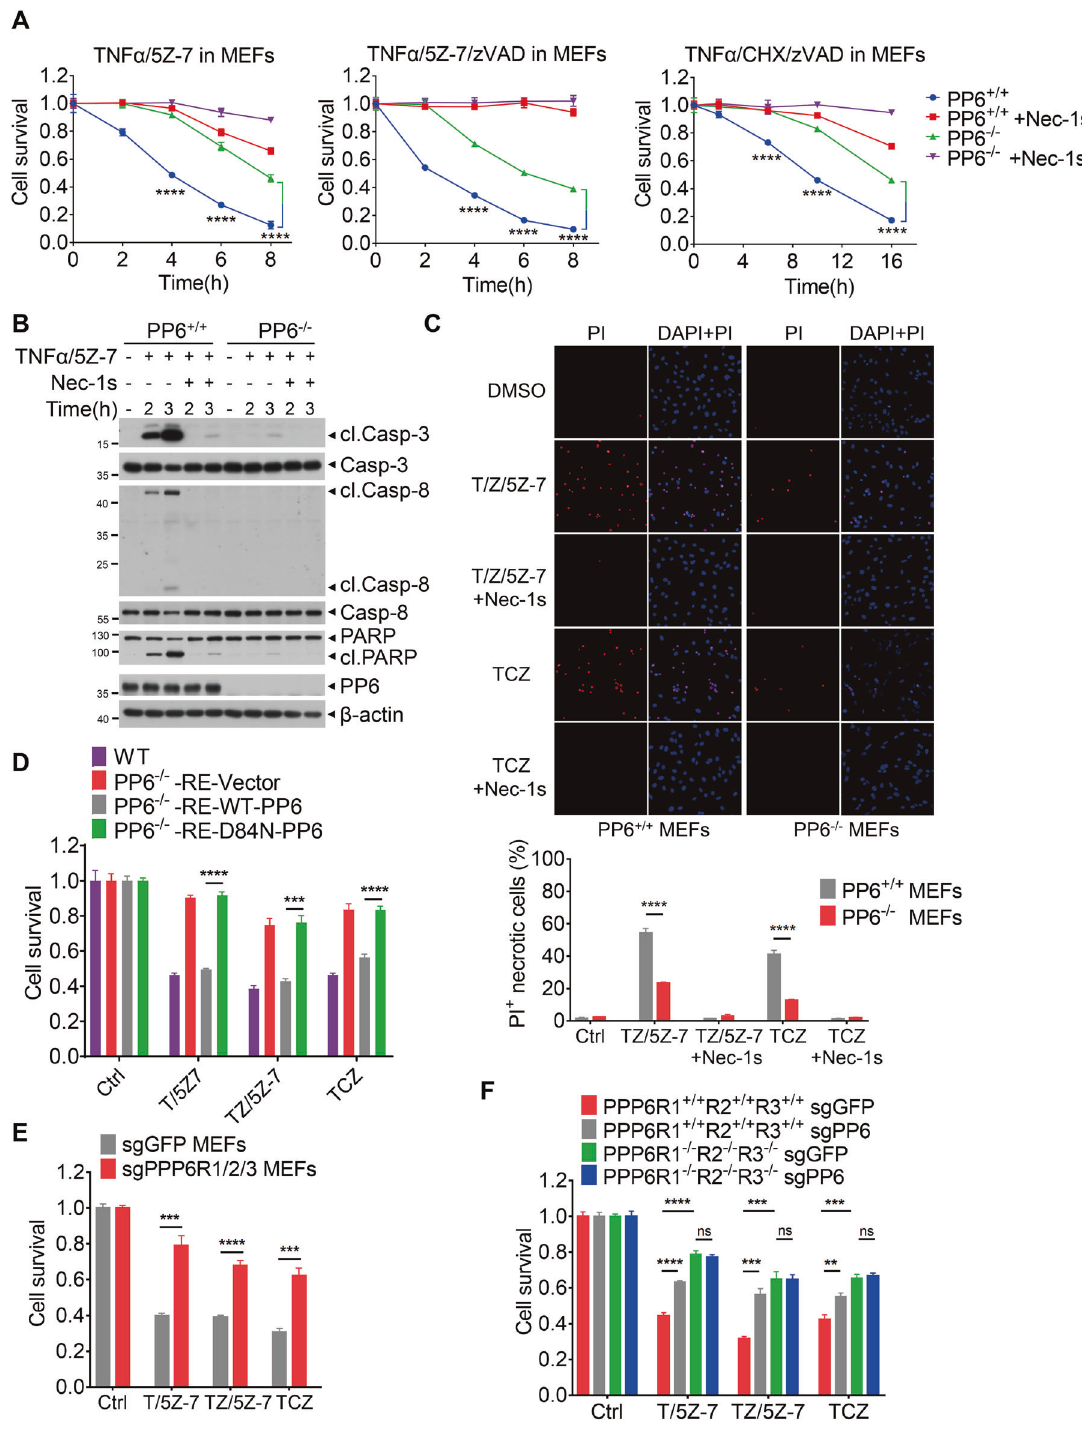
Fig. 3 PP6 also promotes TNF α -mediated RIPK1-dependent cell death. A PP6 + / + or PP6 − / − MEFs were pretreated with Nec-1s for 1 h and then treated with TNF α /5Z-7, TNF α /zVAD/5Z-7 or TNF α /zVAD/CHX for indicated periods of time. B PP6 + / + or PP6 − / − MEFs were pretreated with Nec-1s for 1 h and then treated with TNF α /5Z-7 for indicated periods of time. Cells were lysed with RIPA buffer and analyzed by western blotting with indicated antibodies. C PP6 + / + or PP6 − / − MEFs were pretreated with Nec-1s for 1 h and then treated with TNF α /zVAD/5Z-7 for 3 h or TNF α /zVAD/CHX for 6 h. Cells were stained with DAPI and PI. The panel below showed the quanti fi cation result of PI positive cells. D PP6 − / − MEFs were reconstituted with control vector, WT-PP6 or phosphatase-inactive D84N-PP6. Cells were then treated with TNF α /5Z-7 and TNF α /zVAD/5Z-7 for 4 h or TNF α /zVAD/CHX for 8 h. E WT or PPP6R1/2/3 triple-knockout MEFs were treated with TNF α /5Z-7 and TNF α / zVAD/5Z-7 for 4 h or TNF α /zVAD/CHX for 8 h. F PP6 was removed in WT or PPP6R1/2/3 triple-knockout MEFs. Cells were treated with TNF α /5Z- 7 and TNF α /zVAD/5Z-7 for 4 h or TNF α /zVAD/CHX for 8 h. Concentrations of reagents used: TNF α (T), 50 ng/ml; CHX (C), 2 μ g/ml; Nec-1s, 10 μ M; zVAD (Z), 50 μ M; 5Z-7, 300 nM. The cell death in ( A , D – F ) was measured by CellTiter-Glo assay. Data represent mean ± SD of three independent experiments (Student ’ s t test ** P < 0.01; *** P < 0.001; **** P < 0.0001, ns not signi fi cant).